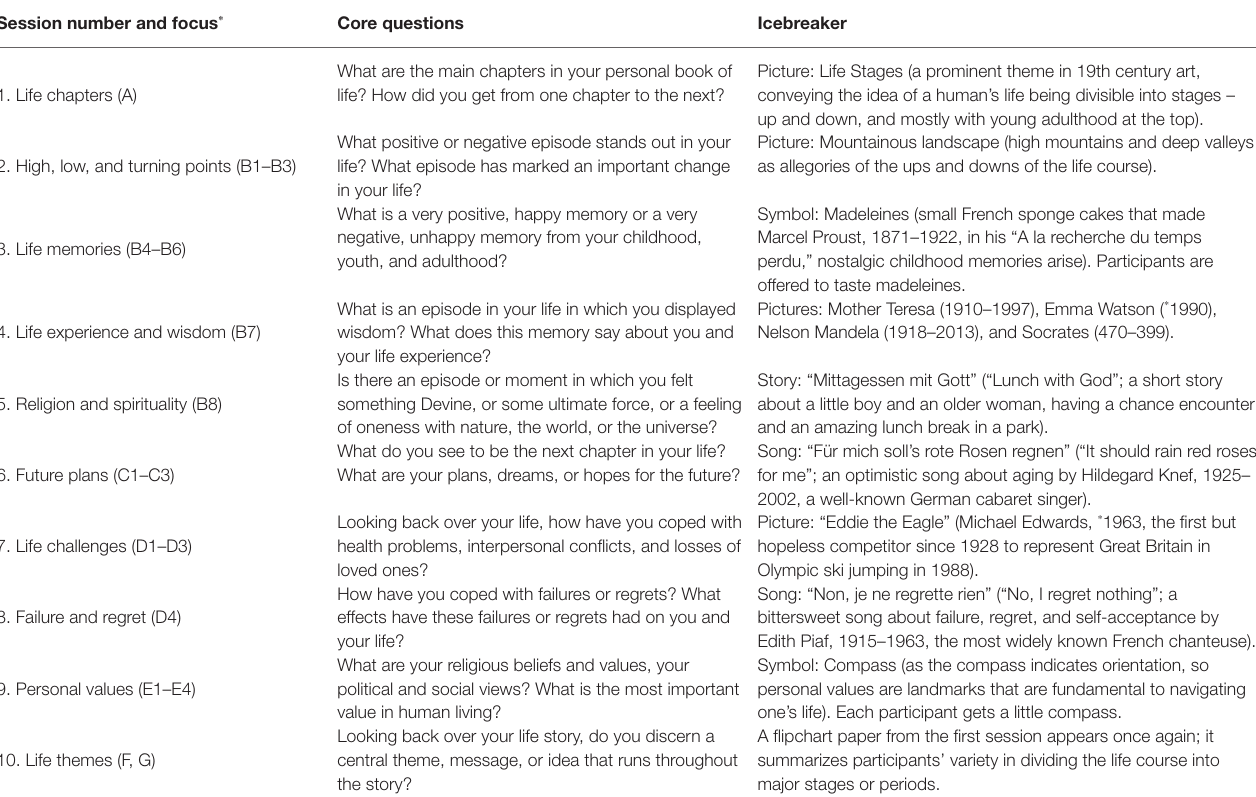
TABLE 1 | Overview of the 10 Life Story Encounter Program (LSEP)